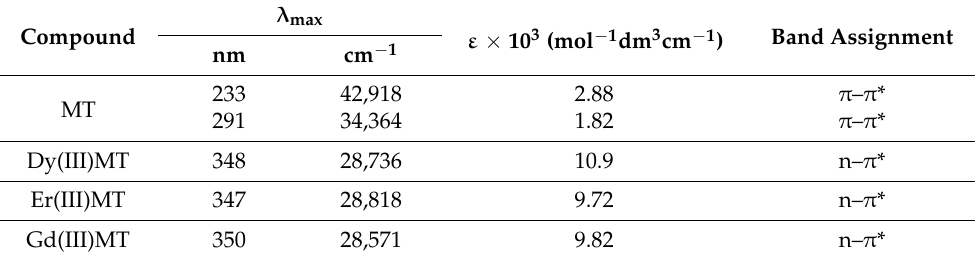
Table 2. Electronic absorption data of 2,4,6-tris(4-carboxybenzimino)-1,3,5-triazine (MT) and its